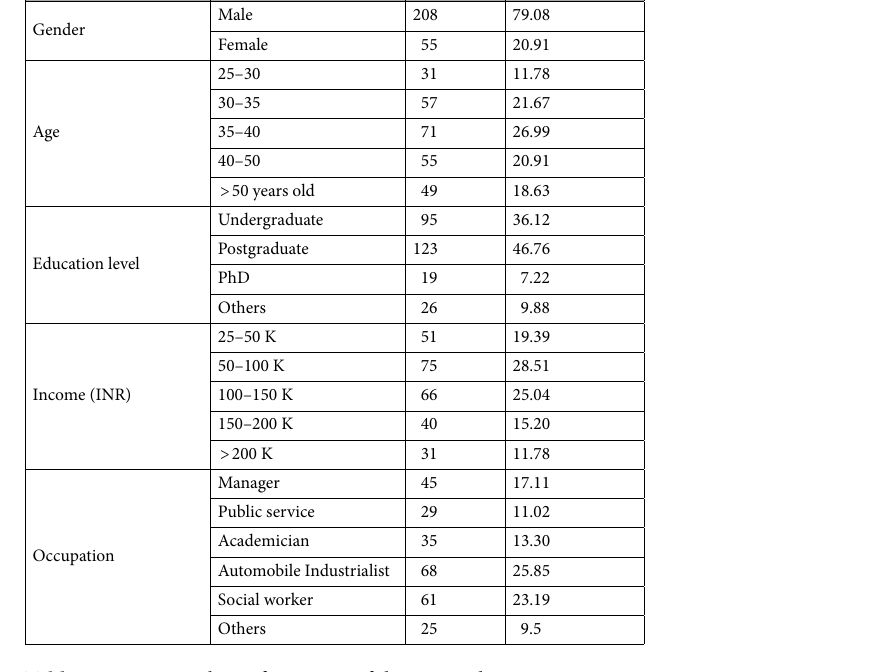
Table 1. Demographic information of the